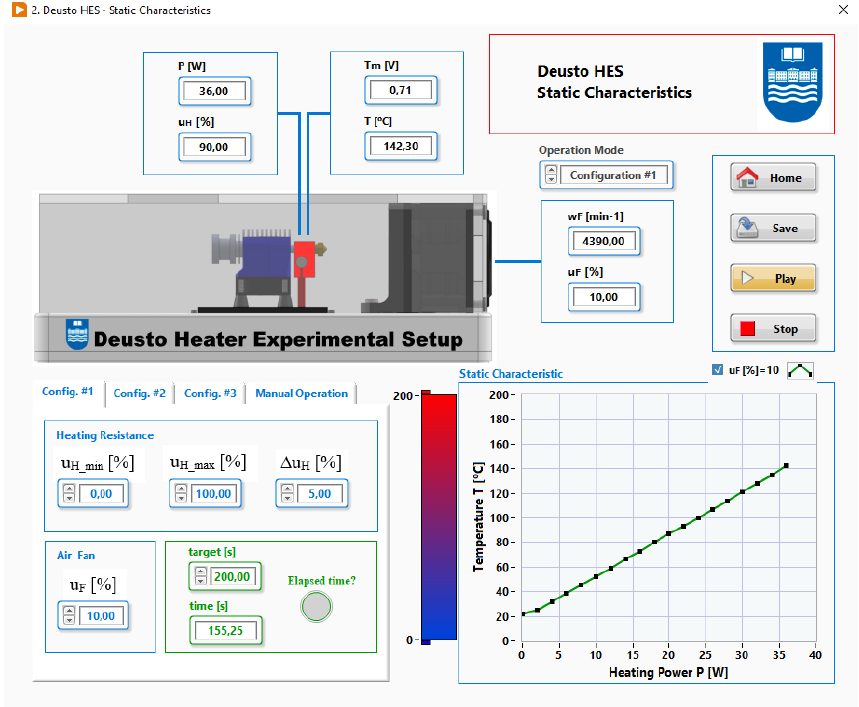
Figure 17. LabVIEW-based application for obtaining static characteristics for different configurations of the controlled process and different operating points.